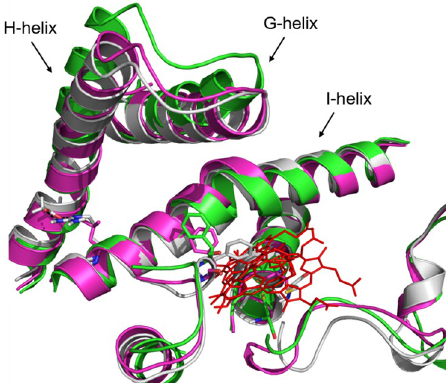
Figure 9. ( A ) Calculated distance between C5-atom of substrate and iron-bound oxygen species. ( B ) Calculated angle between benzo-1,4-dioxane substrate and heme required for the hydroxylation of benzo-1,4-dioxane in WT and variants R255G and R255L along three independent 50 ns molecular dynamics (MD) simulation trajectories.